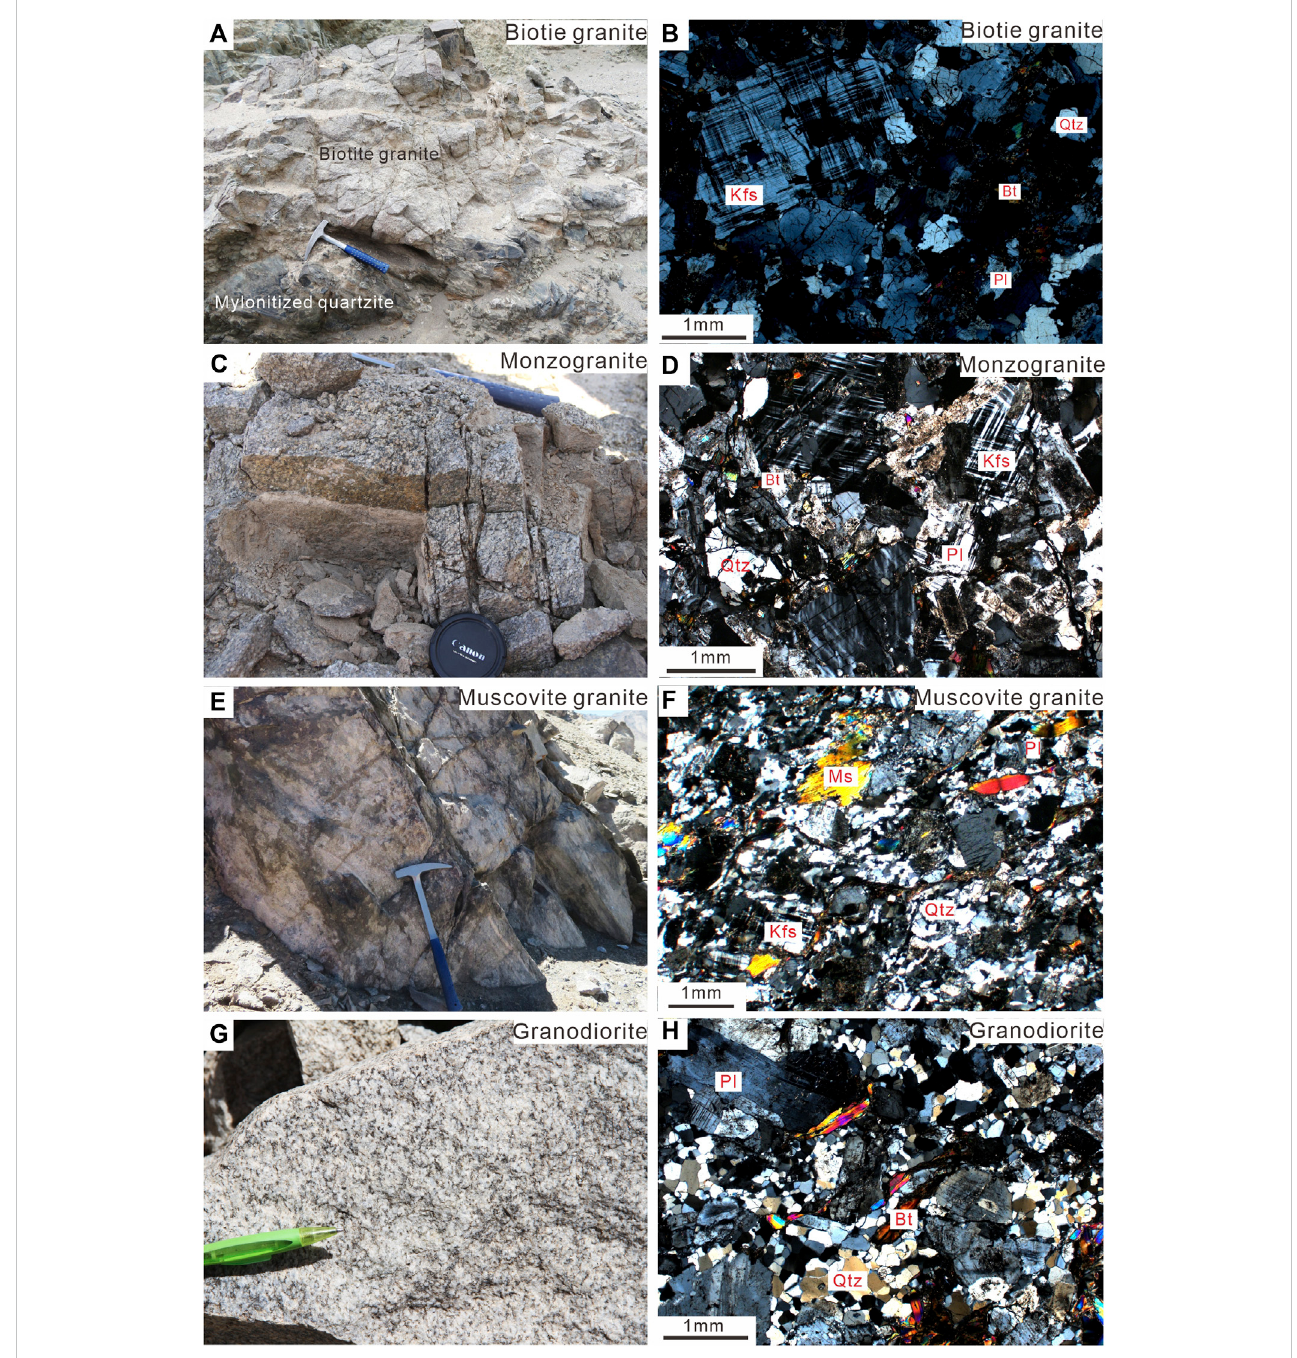
FIGURE 2 Field photographs and photomicrographs of (A,B) biotite granite, (C,D) monzogranite, (E,F) muscovite granite, and (G,H) granodiorite in the Huatugou area. Bt, biotite; Kfs, K-feldspar; Ms, muscovite; Pl, plagioclase; Qtz, quartz.